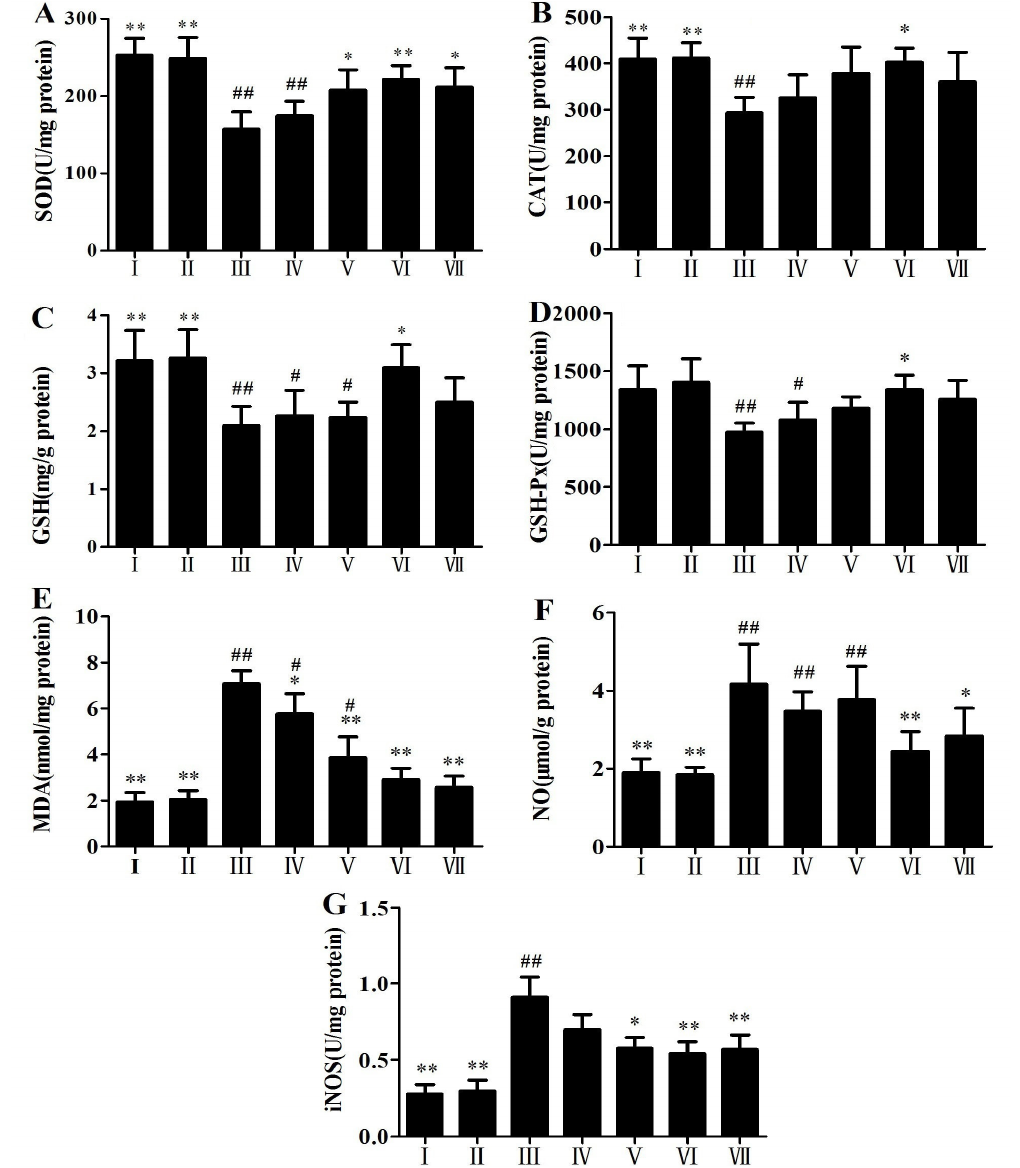
Figure 2. Effects of RLTS on the levels of SOD ( A ), CAT ( B ), GSH ( C ), GSH-Px ( D ), MDA ( E ), NO ( F ) and iNOS ( G ) in livers. I: RLTS control; II: normal control; III: model; IV: RLTS (100 mg/kg); V: RLTS (200 mg/kg); VI: RLTS (300 mg/kg); VII: silymarin (200 mg/kg). Values are expressed as mean ± SD ( n = 10). * p < 0.05, ** p < 0.01 vs. model group; ## p < 0.01, # p < 0.05 vs. normal